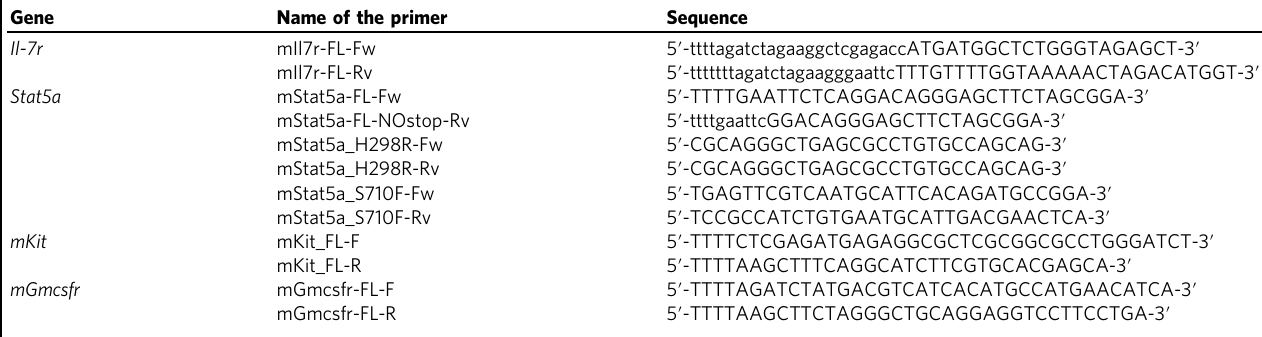
Table 3 Primers used for cloning of murine